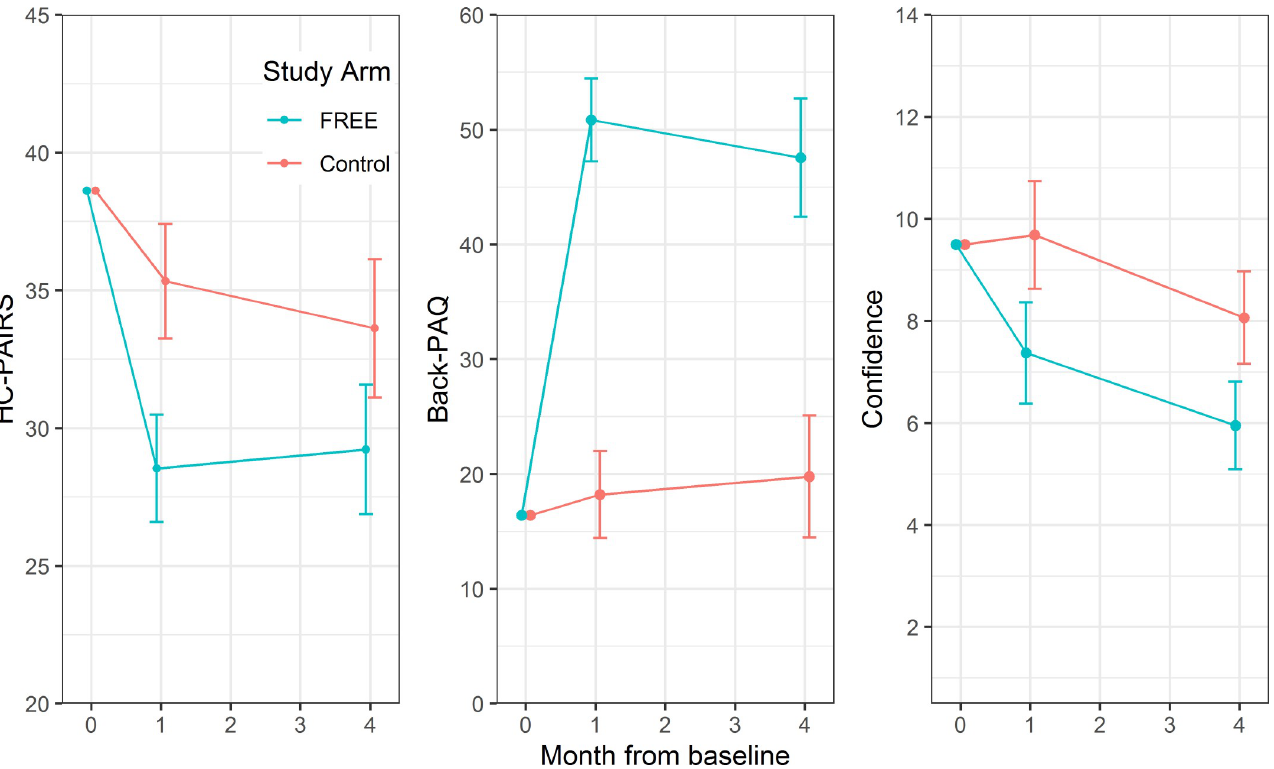
Fig 4. Mean GP participant HC-PAIRS, Back-PAQ, and confidence to manage LBP scores by study arm at baseline and follow-up. Error bars represent 95% CIs of mean. Back-PAQ, Back Pain Attitudes Questionnaire; FREE, Fear Reduction Exercised Early; GP, general practitioner; HC-PAIRS, Health Care Providers Pain and Impairment Relationship Scale.